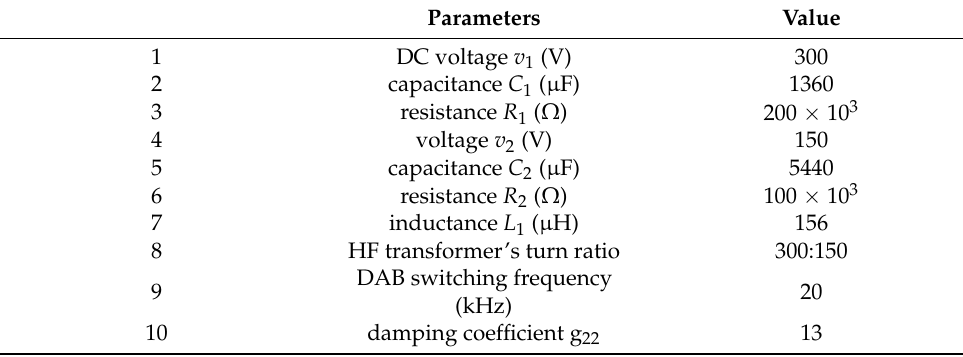
Table 2. Main parameters of DAB converter